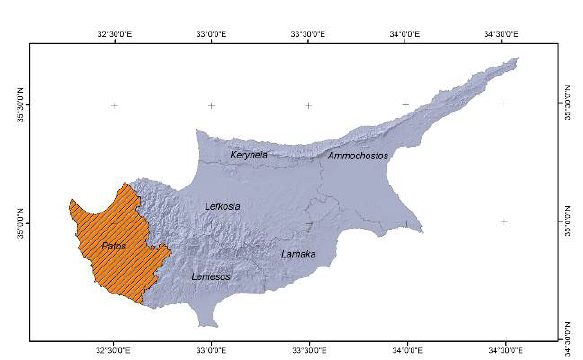
Figure 1. District of Paphos, situated in the western part of the Cyprus island